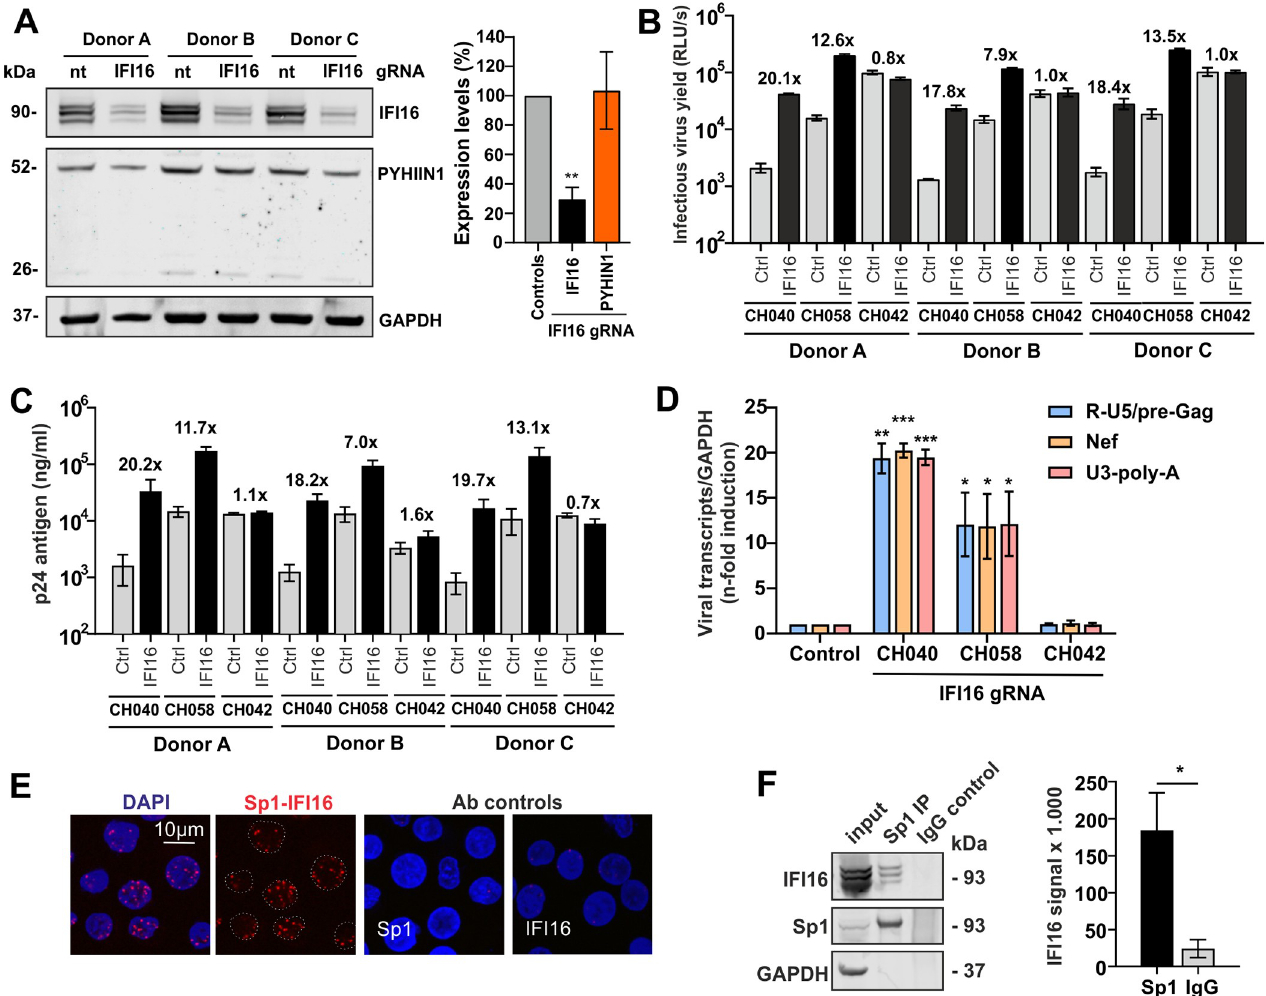
Fig 4. IFI16 restricts HIV-1 and interacts with Sp1 in primary CD4+ T lymphocytes. Endogenous IFI16 inhibits HIV-1 in primary CD4 + T lymphocytes. Cells from three healthy donors were isolated and activated with IL-2 and anti-CD3/CD28 beads. 72 hours post-activation, cells were transfected with Cas9 in complex with either a non-targeting (nt) or an IFI16-specific gRNA. At 96 hours post-transfection, cells were transduced with the indicated VSV-G pseudotyped HIV-1 strains. (A-D) The reduction of IFI16 protein levels in infected cell cultures (A), the infectious virus yield (B), p24 antigen production (C) and levels of viral RNA transcripts (D) were determined by Western blot, TZM-bl infection assay, ELISA and qRT-PCR, respectively, three days post infection. Bar diagrams in panel A and D show mean values ( ± SD) of the three different donors; those in panel B and C from triplicate measurements. Numbers above bars indicate n-fold change between cells treated with control or IFI16 specific gRNA. � p < 0.05, �� p < 0.01, ��� p < 0.001. (E) Association of Sp1 and IFI16 by in situ PLA. (F) Sp1 co-precipitates with IFI16 and PYHIN in CD4 + T lymphocytes. Cells from three healthy donors were isolated and activated with IL-2 and anti-CD3/CD28 beads. 72 hours post activation, cells were lysed and endogenous Sp1 was immunoprecipitated using magnetic beads coated with either an Sp1 antibody or control IgG. Co-IP eluates and input controls were subsequently analysed by Western Blotting. Shown is the blot of one representative experiment. On the right-hand panel, the IFI16 signal intensity from three independent experiment ( ± SEM) is